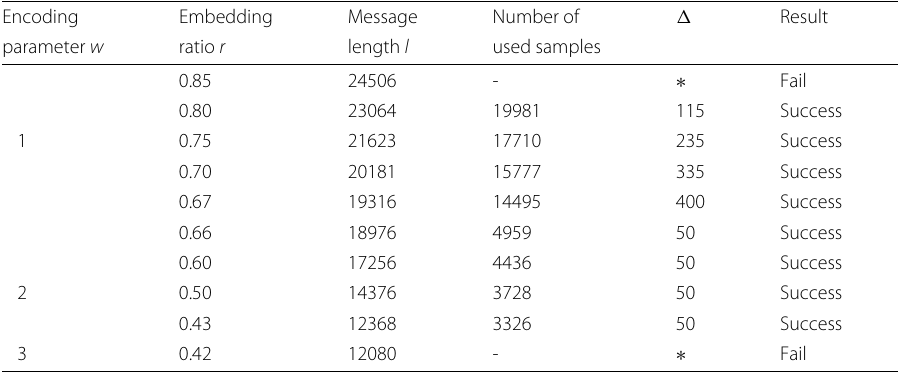
Table 3 Experimental results of stego key recovery for F5 steganography Encoding Embedding Message Number of (cid:5) Result parameter w ratio r length l used samples 0.85 24506 - ∗ Fail 0.80 23064 19981 115 Success 1 0.75 21623 17710 235 Success 0.70 20181 15777 335 Success 0.67 19316 14495 400 Success 0.66 18976 4959 50 Success 0.60 17256 4436 50 Success 2 0.50 14376 3728 50 Success 0.43 12368 3326 50 Success 3 0.42 12080 - ∗